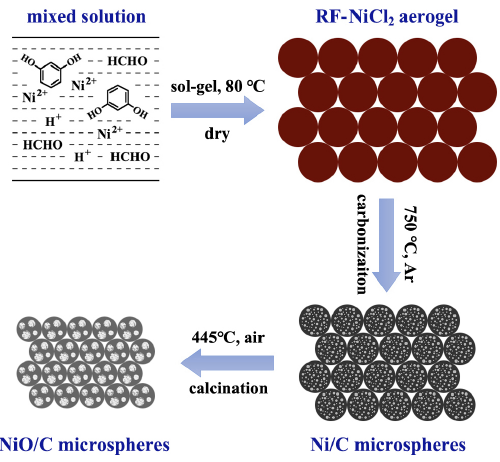
Figure 1. Schematic diagram of the material preparation process.